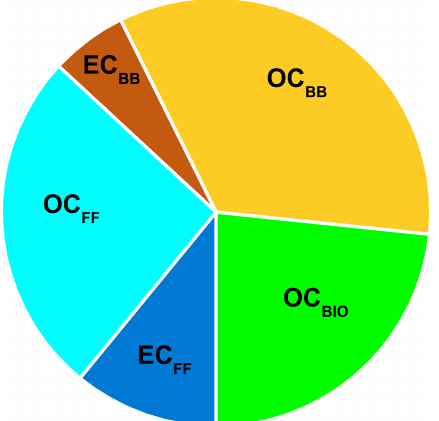
Figure 4. Median relative contributions of EC FF (11.2%), OC FF (27%), EC BB (5.9%), OC BB (34%) and OC BIO (24%) to the total carbon with a median atmospheric concentration of 6.0µgm − 3 in the PM 2 . 5 size fraction in central Budapest.